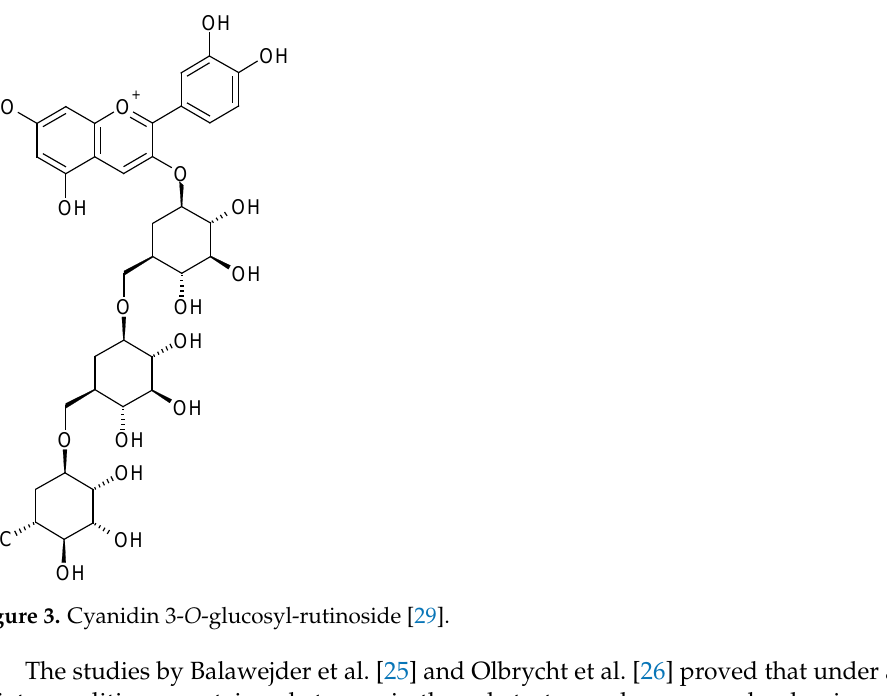
Figure 2. Cyanidin 3- O -sophoroside [28].